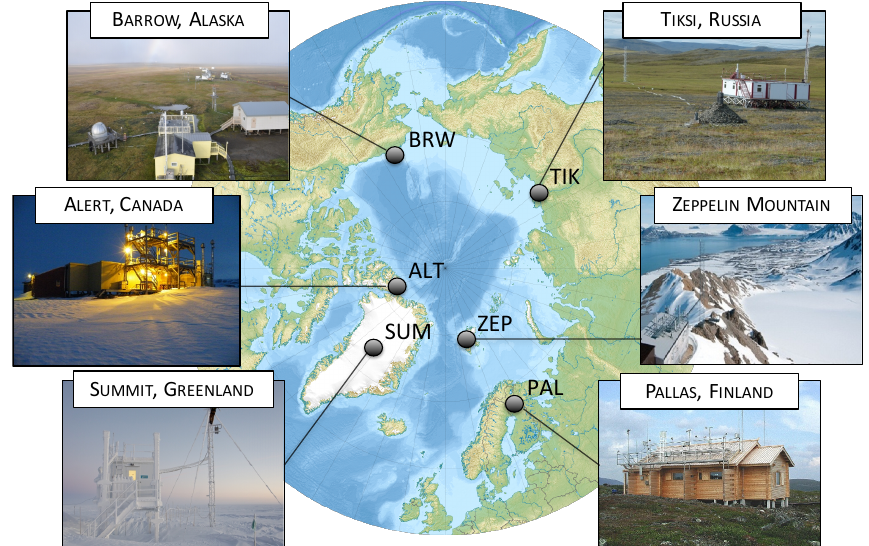
Figure 1. Map of Arctic monitoring stations with pictures of each